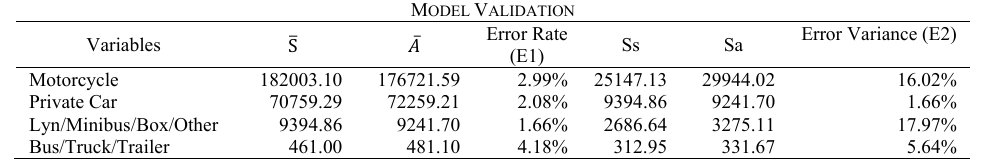
TABLE 1 M ODEL V